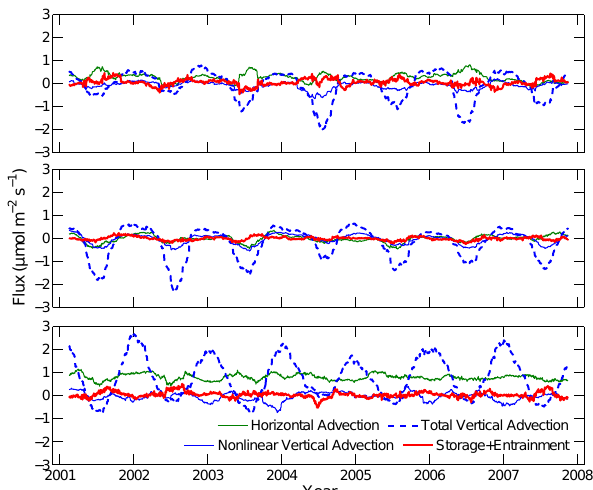
TotalVerticalAdvection NonlinearVerticalAdvection Storage+Entrainment Fig. 4. Contribution of mixed-layer budget terms to the net surface flux calculated from CT/TM5 assimilated concentrations at SGP (a) , LEF (b) , and HFM (c)